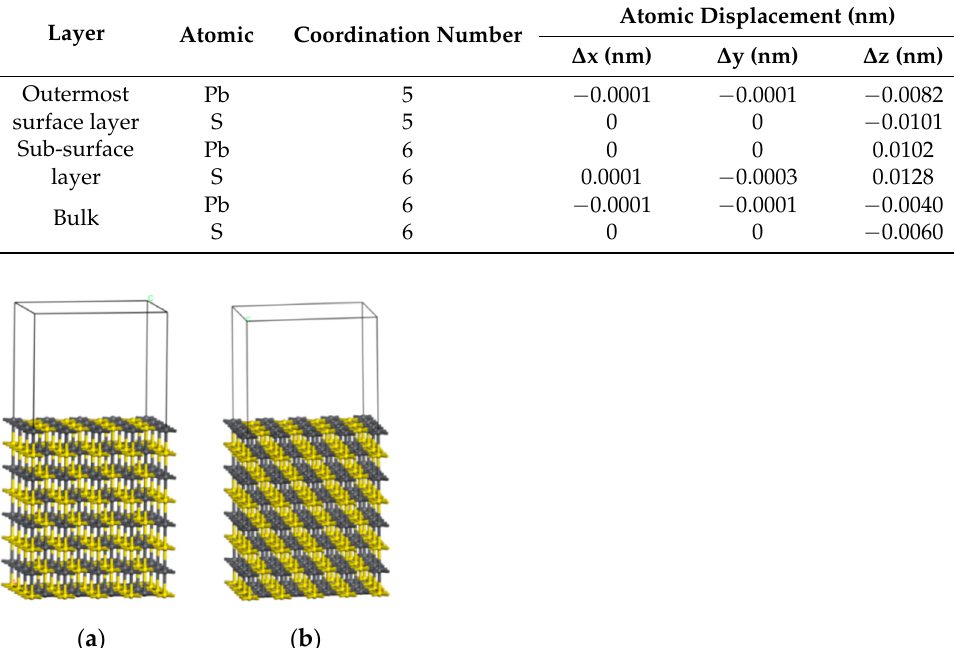
Figure 7. Crystal plane model before and after surface relaxation on (100) cleavage surface of galena (Yellow: S atoms; Gray: Pb atoms). ( a ) Before surface relaxation; ( b ) After surface relaxation.